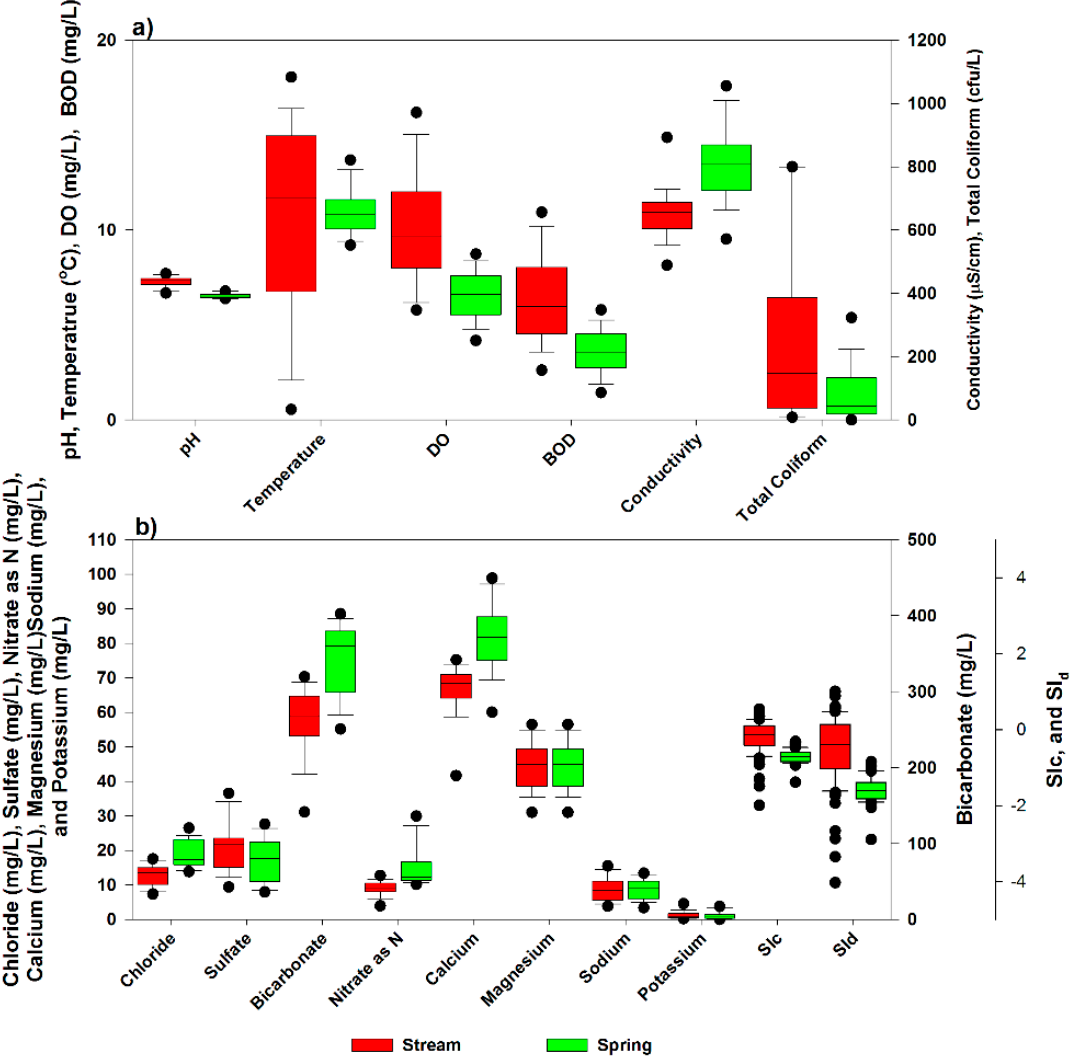
Figure 2. Box and whisker plots for the 16 water quality parameters measured among the streams (red) and springs (green). ( a ) Field parameters. ( b ) Chemical parameters. The ends of the boxes represent the 25th and 75th percentiles with the solid line at the median; the error bars depict the 10th and 90th percentiles and the points represent the 5th and 95th percentiles.